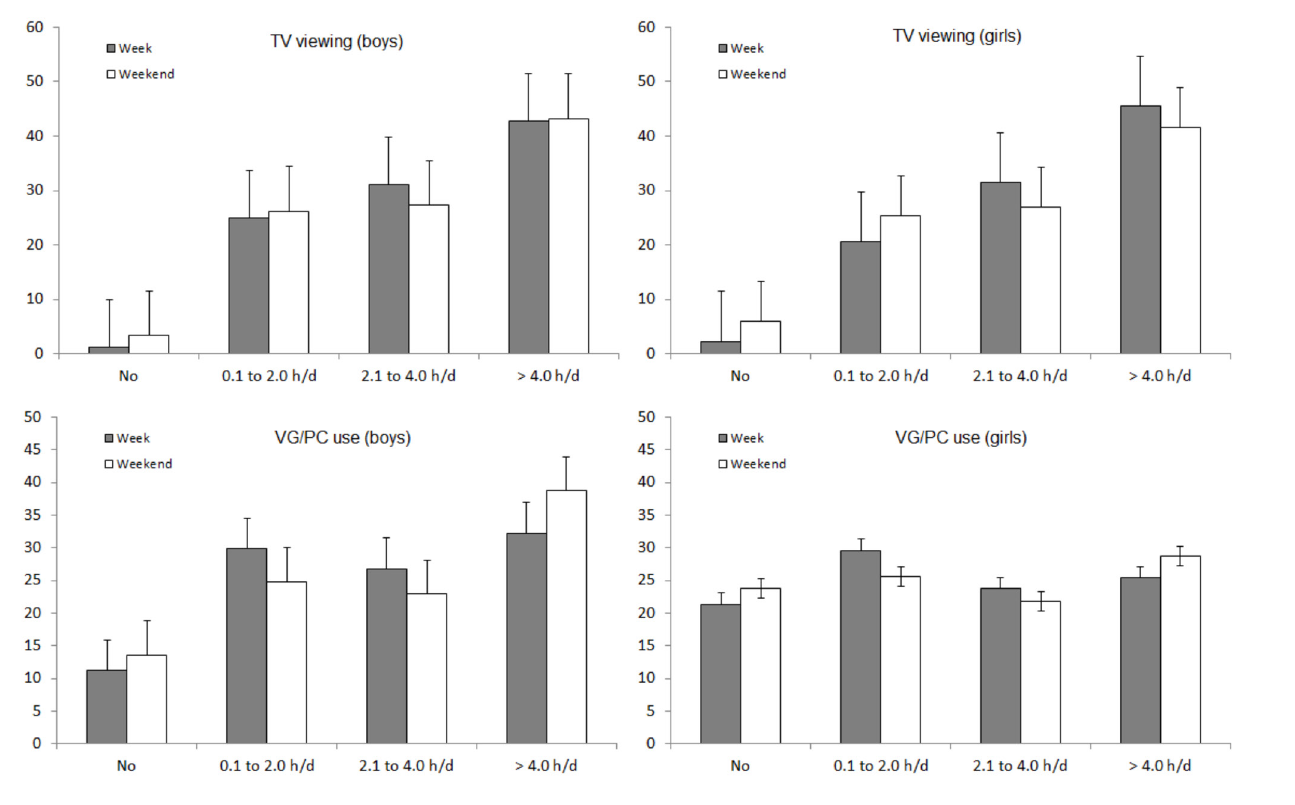
Figure 1. Distribution of sedentary behavior contexts in Brazilian adolescents.